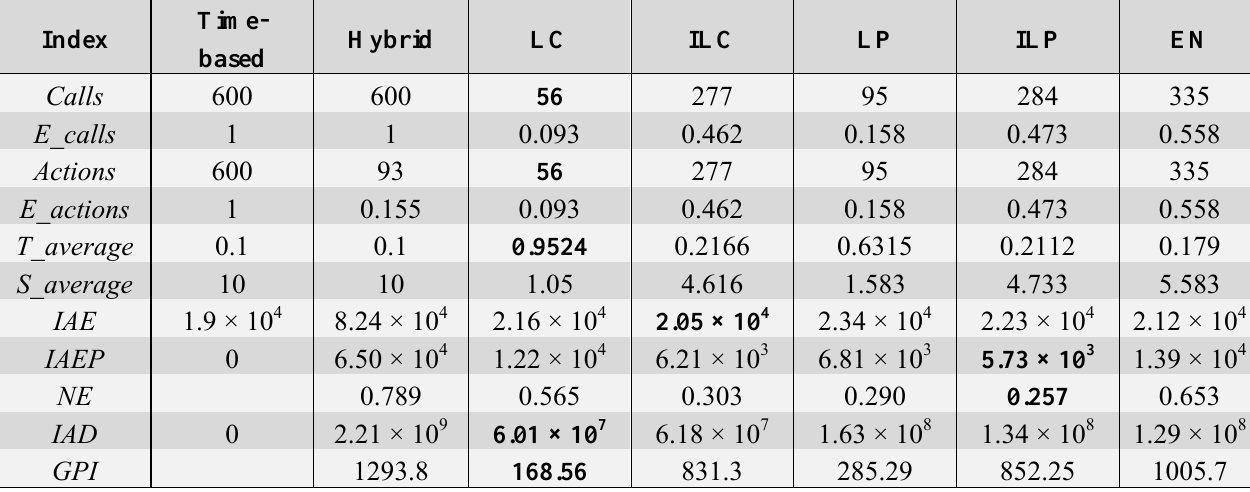
Table 9. Performance of the hybrid and event-based approaches for  disturbance. Figures in bold represent the best value of every performance index in the hybrid and event-based